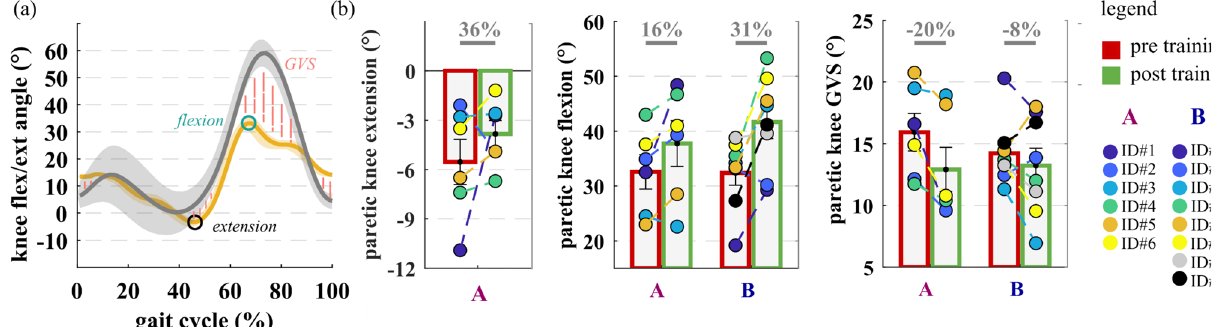
Figure 6. Paretic knee kinematics pre and post training. ( a ) A graphical schematic representation of parameters considered for the analysis. Knee flexion–extension profiles of healthy subjects (grey) and of a study participant (orange) are depicted. ( b ) From left to right, paretic knee extension peak during stance for the A group, paretic knee flexion peak during swing and gait variable score (GVS) for the paretic knee flexion/extension angle profile for both groups A and B, measured during gait analysis pre (red) and post (green) training are shown. Grouped data (i.e. group A, group B) are reported in bar plots as mean and standard errors. Circles represent individual study